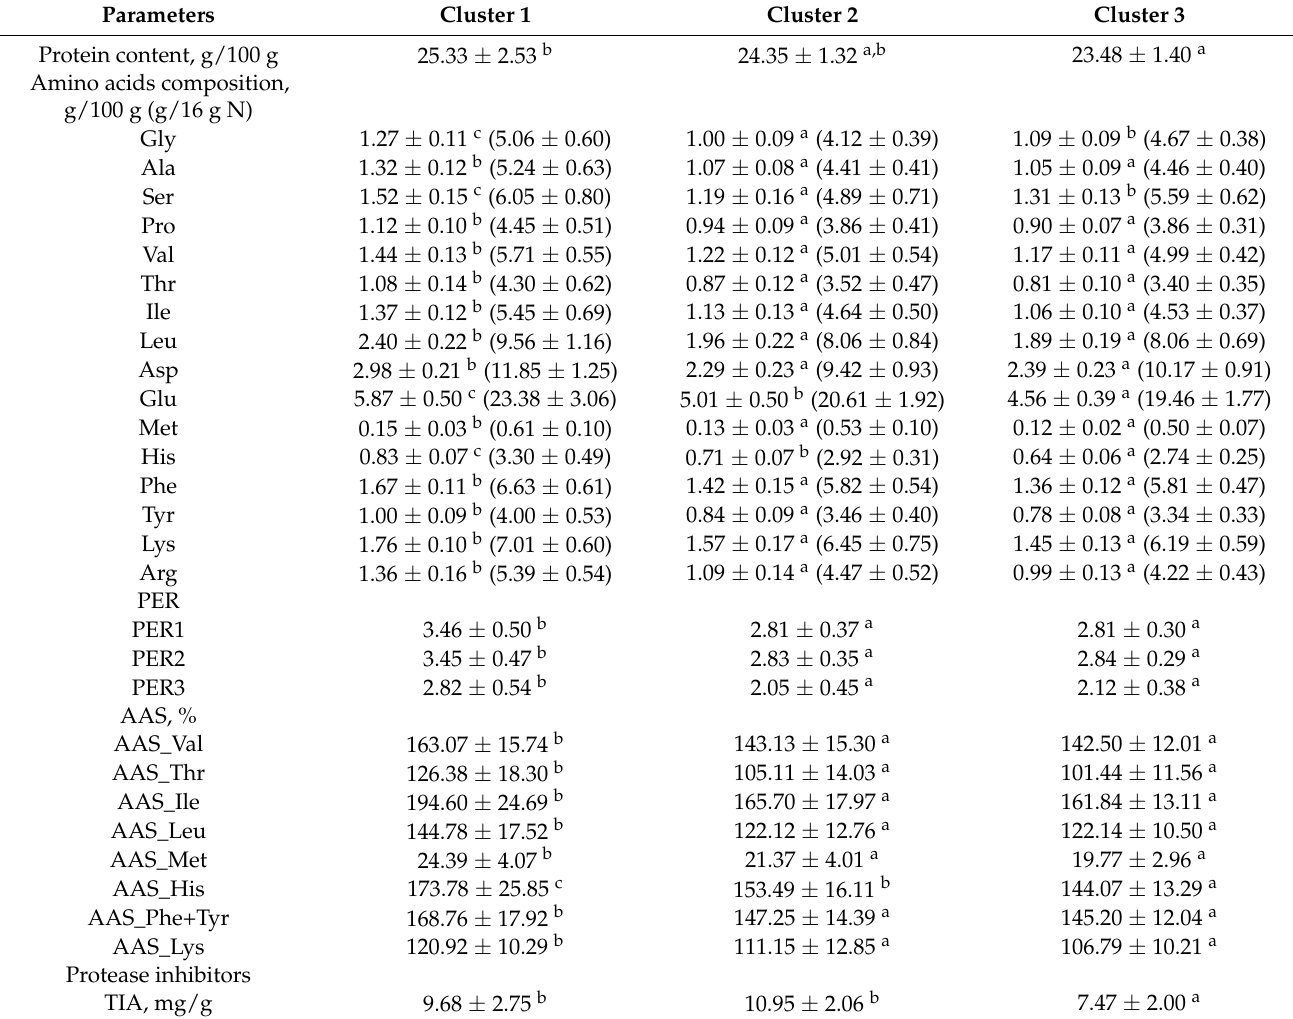
Table 2. Protein quality (protein content, amino acid content, protein efficiency ratio, PER and amino acid score, AAS), and trypsin inhibitor activity, TIA, considering the clusters established for common bean accessions cropped in C ó rdoba ( n = 72). Results were shown as the average ± standard deviation. In each row, different letters indicate significant differences between clusters ( p < 0.05) and equal letters the absence of differences ( p >